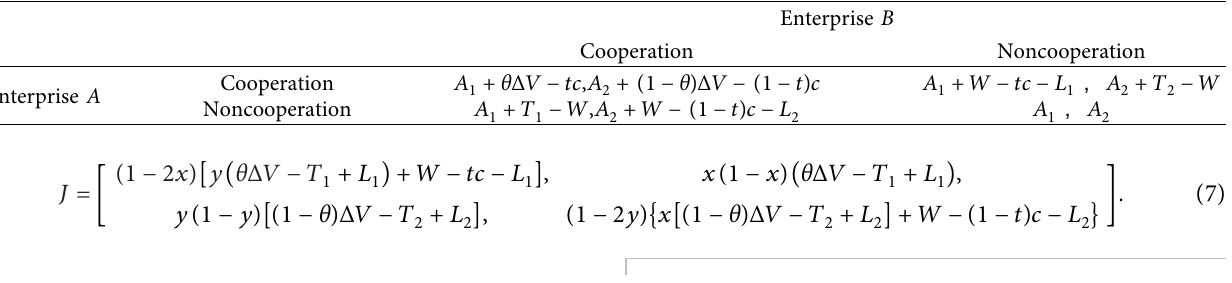
Table 1: The income matrix of the game between technology-based SME A and B . Enterprise B Cooperation Noncooperation Enterprise